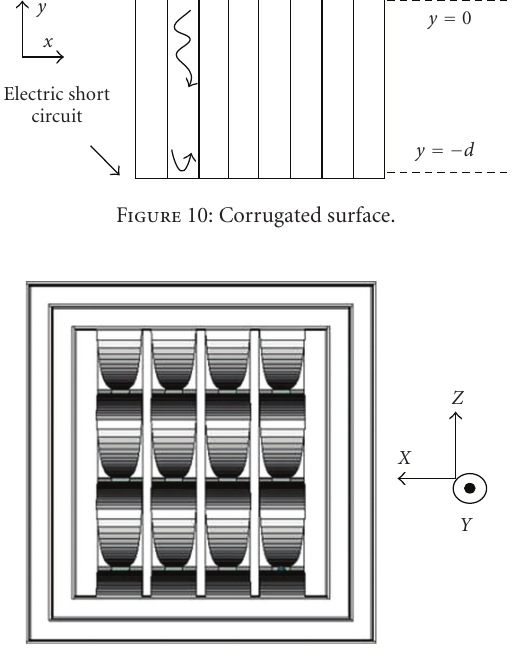
Figure 11: UWB antenna array with